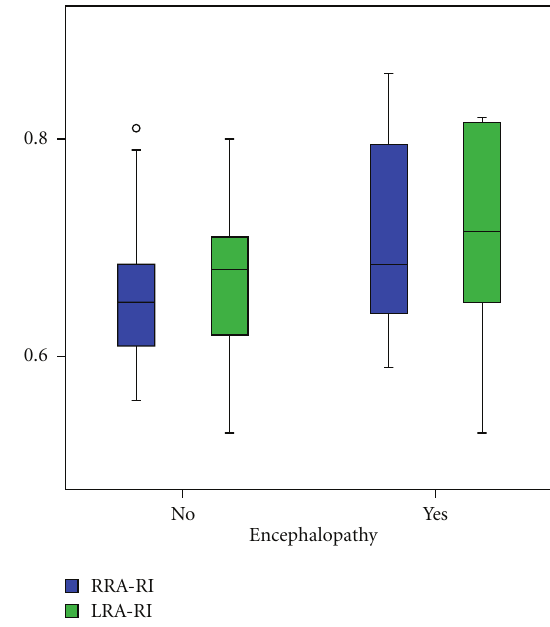
Figure 6: The values of RRA/LRA-RI in patients with presence or absence of hepatic